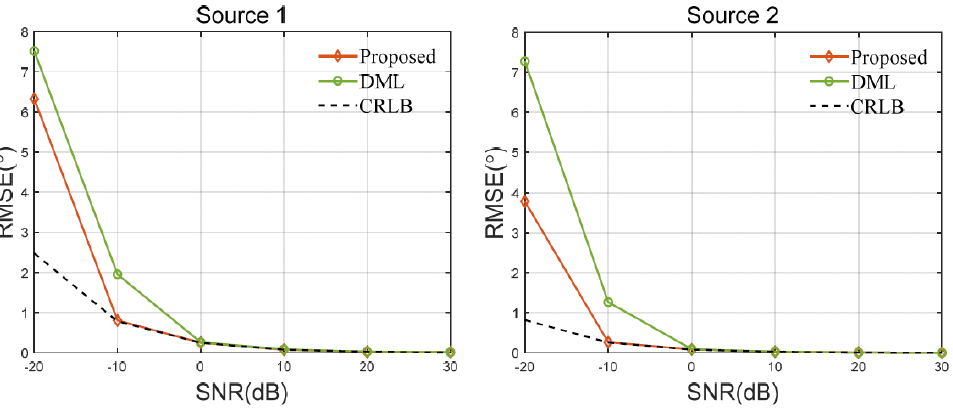
Figure 2. RMSE and CRLB versus SNR of the estimated parameter 𝜃 .